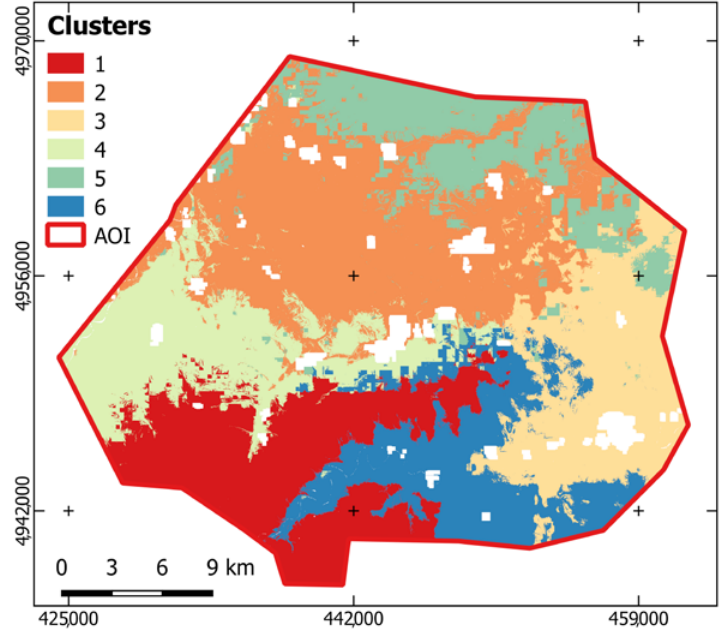
Figure 10. Clusters from k - means. The optimal number in AOI was found to be 6. (EPSG: 32,632, WGS 84 UTM 32N). Table 2. Cluster area size (ha and %) resulting from classification.